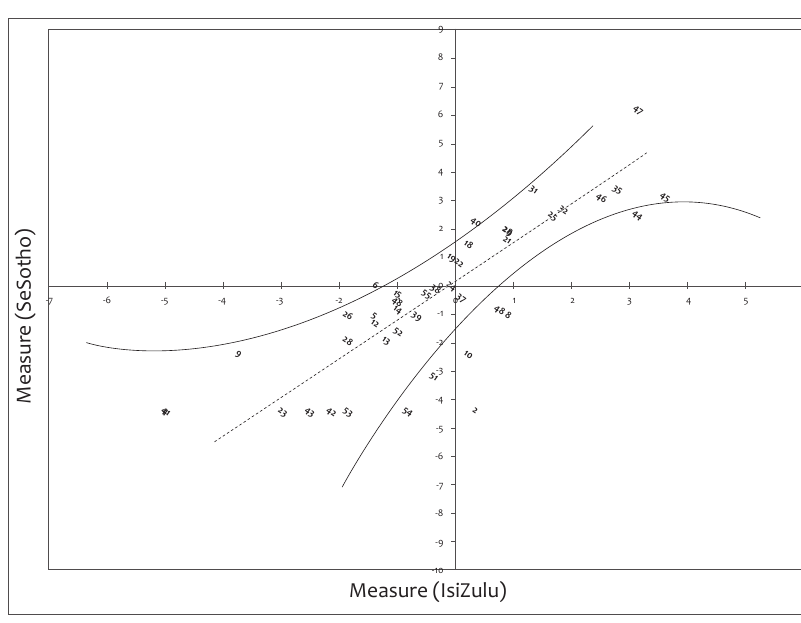
Figure 5: isiZulu-Sesotho comparison